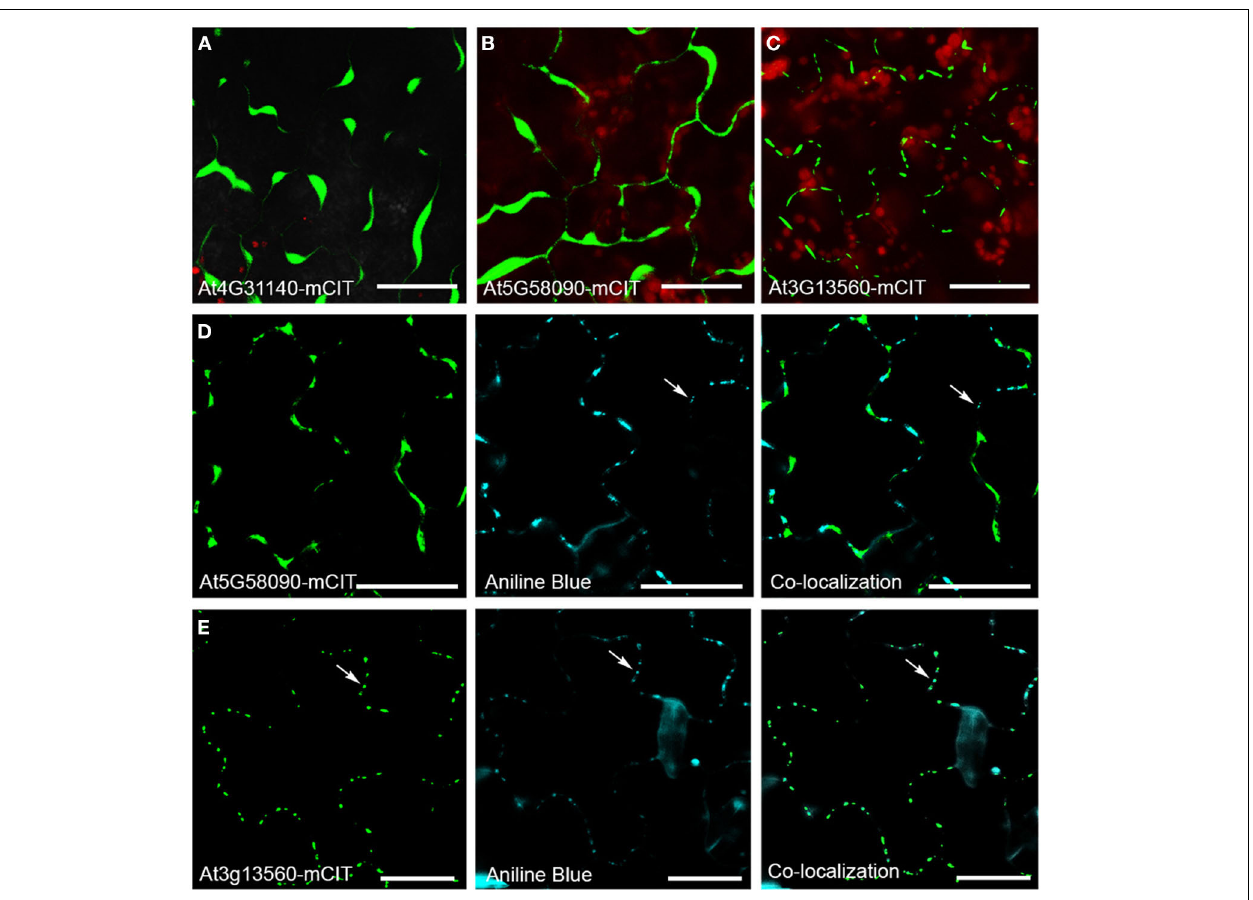
FIGURE 5 | Intracellular localization of GHL17 protein m-Citrine fusions. (A,B,C) Show At4g31140-mCit, At5g58090-mCitm, and At3g13560-mCit transient expression in tobacco leaves. Chloroplast auto-fluorescence appears in red. (D,E) Show At5g58090-mCit and At3g13560-mCit fluorescence (green) in Arabidopsis leaves expressing